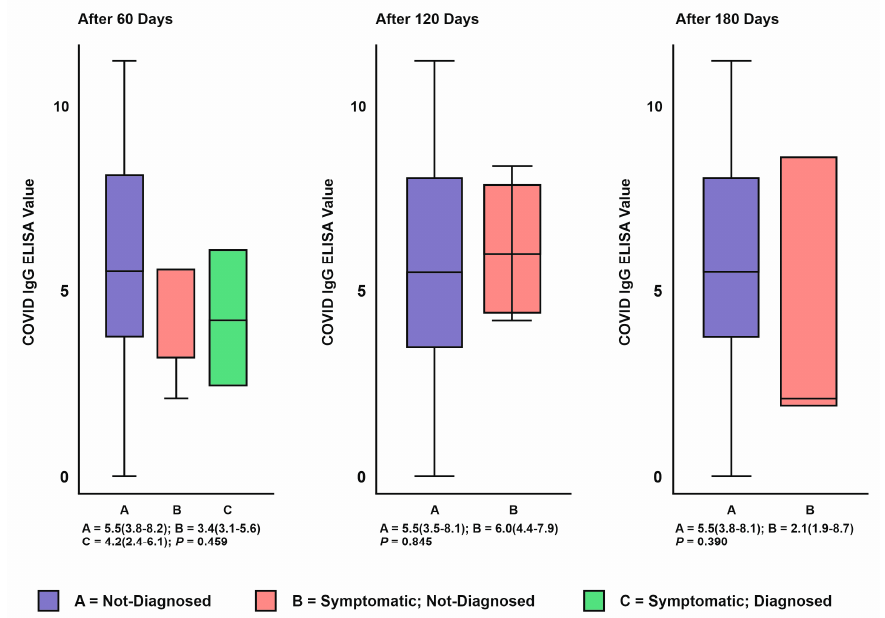
Figure 5. Difference in COVID-19 IgG antibody levels among the symptomatic RT-PCR proven and unproven cases in vaccinated individuals during the 6 months follow up.